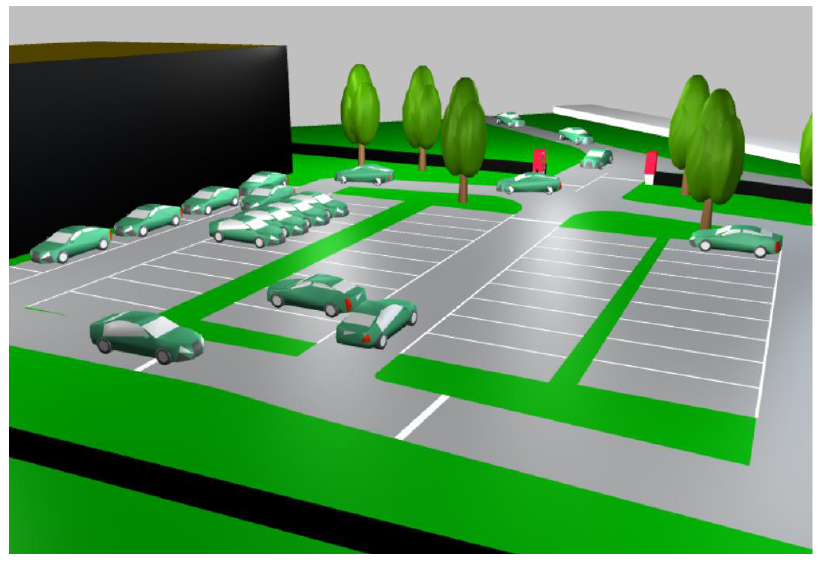
Figure 10. A 3D animation of the new model.